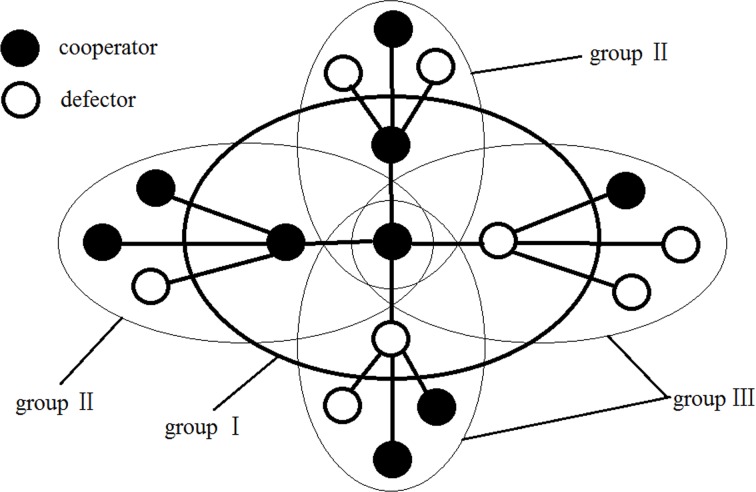
Three types of PGG groups in which a cooperator participate for k = 4.